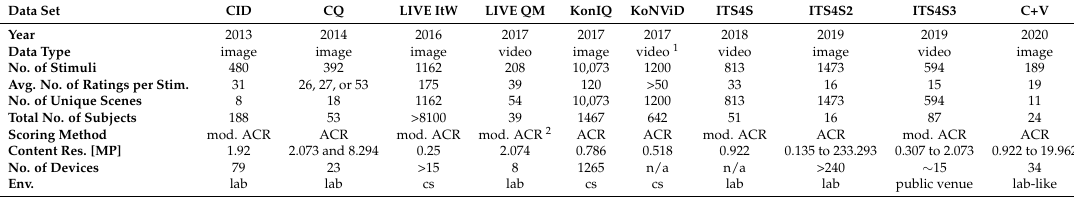
Table 1. A comprehensive comparison of the new CCRIQ2 + VIME1 data set with the similar, existing data sets. We choose to include in the comparison only the data sets that contain user-generated content. This is to assure our comparison addresses only the data sets targeting NR metrics development. The mod. ACR label means a modified version of the classical 5-level ACR method [11] (p. 6) is